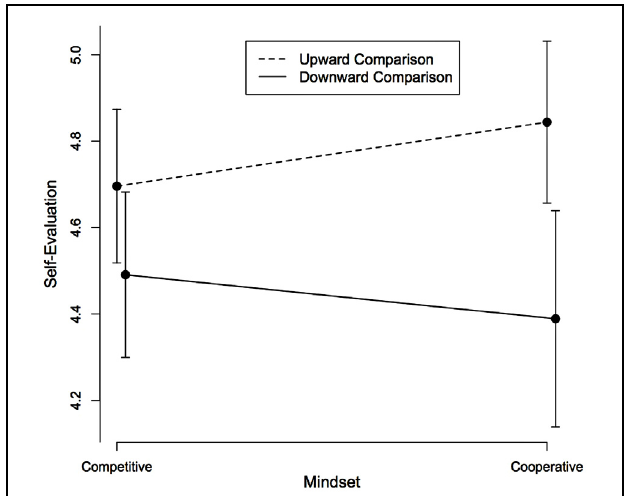
FIGURE 1 | Self-evaluation as a function of the direction of social comparison and the competitive/cooperative mindset. Error bars represent 95% confidence